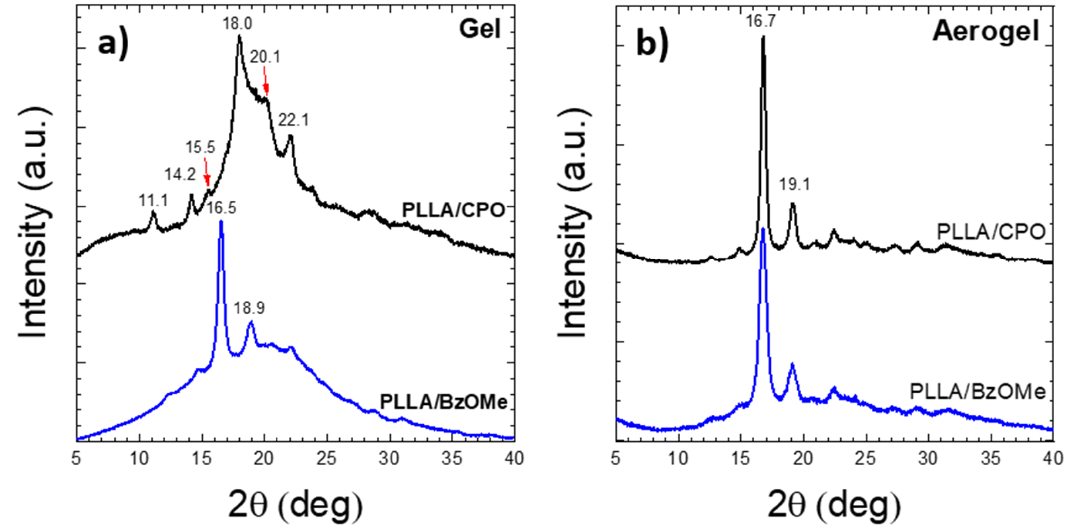
Figure 2. X-ray diffraction patterns of the: ( a ) PLLA gel samples containing CPO (top), or BzOMe (bottom), and ( b ) the relative aerogel samples obtained by solvent extraction with supercritical CO 2 .